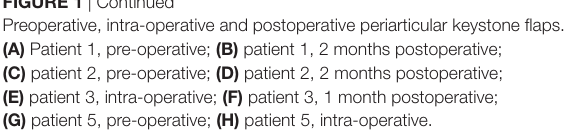
FIGURe 1 | Continued Preoperative, intra-operative and postoperative periarticular keystone